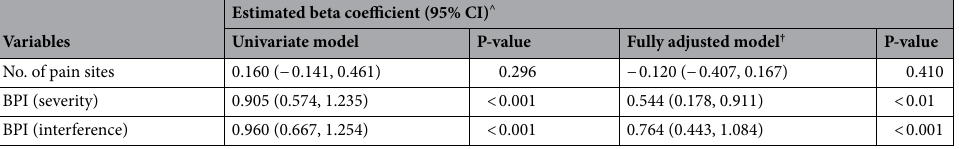
Table 4. Association of pain score with insomnia among participants with MSK pain (n = 248) at 18 months. ^ Abbreviations: CI, confidence interval; BMI: Body Mass Index; BPI: Brief Pain Inventory; MSK: Musculoskeletal; † Adjusted for age, gender, BMI and no. of comorbid diseases.